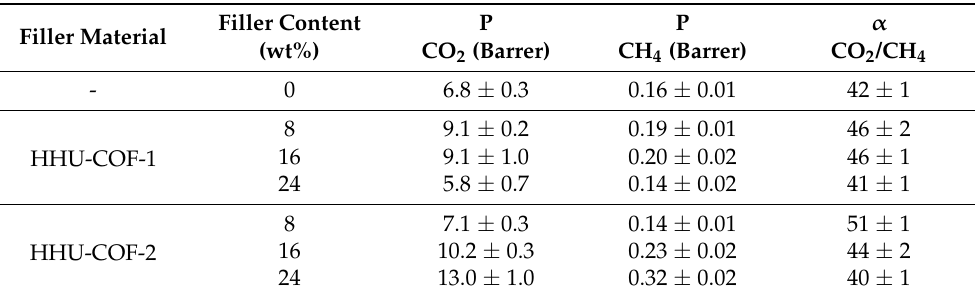
Table 2. Gas permeabilities (P) and mixed-gas selectivity factors (α) of the pristine Matrimid mem- brane and COF/Matrimid MMMs 1 .